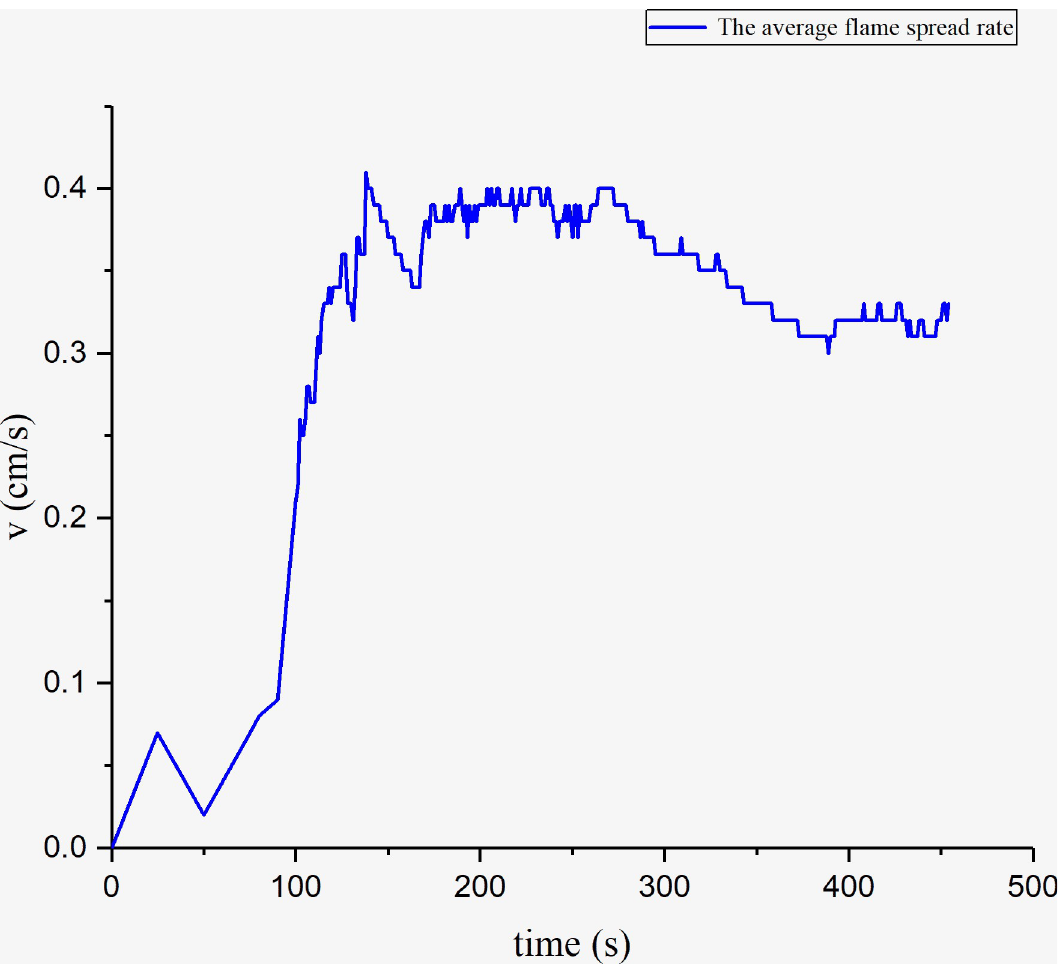
Fig 5. Average cross-sectional flame-spread rate of timber-lining